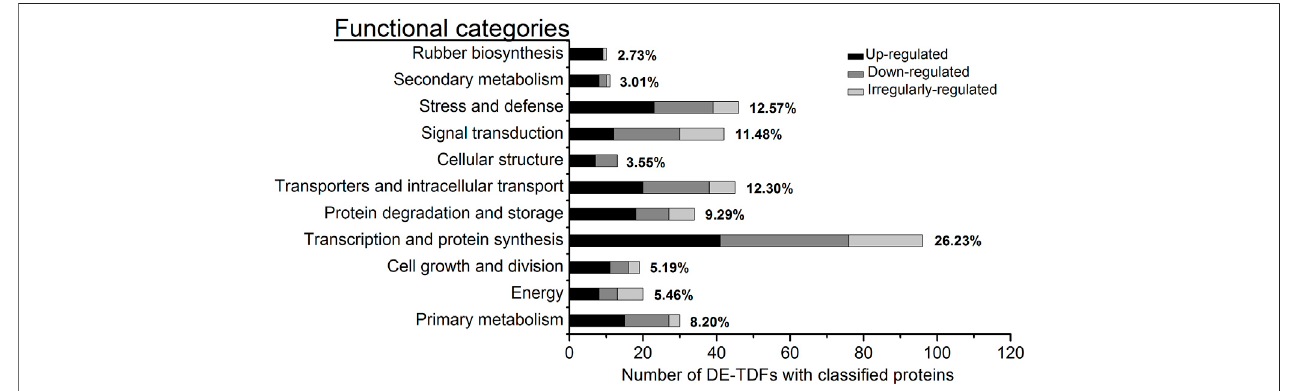
FIGURE3| FunctionalcategoryandpercentageoftheDE-TDFswithknownfunction.The366non-redundantDE-TDFsofannotationproteinswithknownfunction were identi fi ed in the latex for the fi rst fi ve tappings in rubber trees. These DE-TDFs were classi fi ed into 11 functional categories. In each category, the percentage covering the total know functional DE-TDFs was placed at its right whereas the three types of expression were shown in differing gray